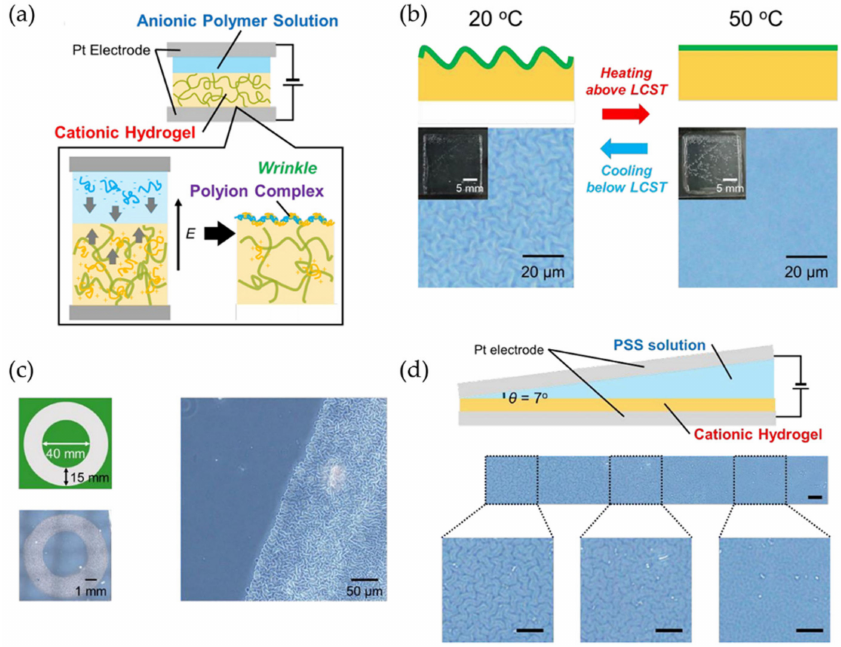
Figure 32. ( a ) Schematic description of the experimental procedure followed to fabricate wrinkled sur- faces, ( b ) stimuli-responsive wrinkle structures at the surface of PNIPAAm hydrogel, ( c ) illustration of the Pt electrode’s insulting mask patterns, and ( d ) schematic representation of the experimen- tal procedure of gradient wrinkle structure formation using sloped electrodes. Reproduced with permission from reference [130]. Copyright 2019, Royal Society of Chemistry (RSC).